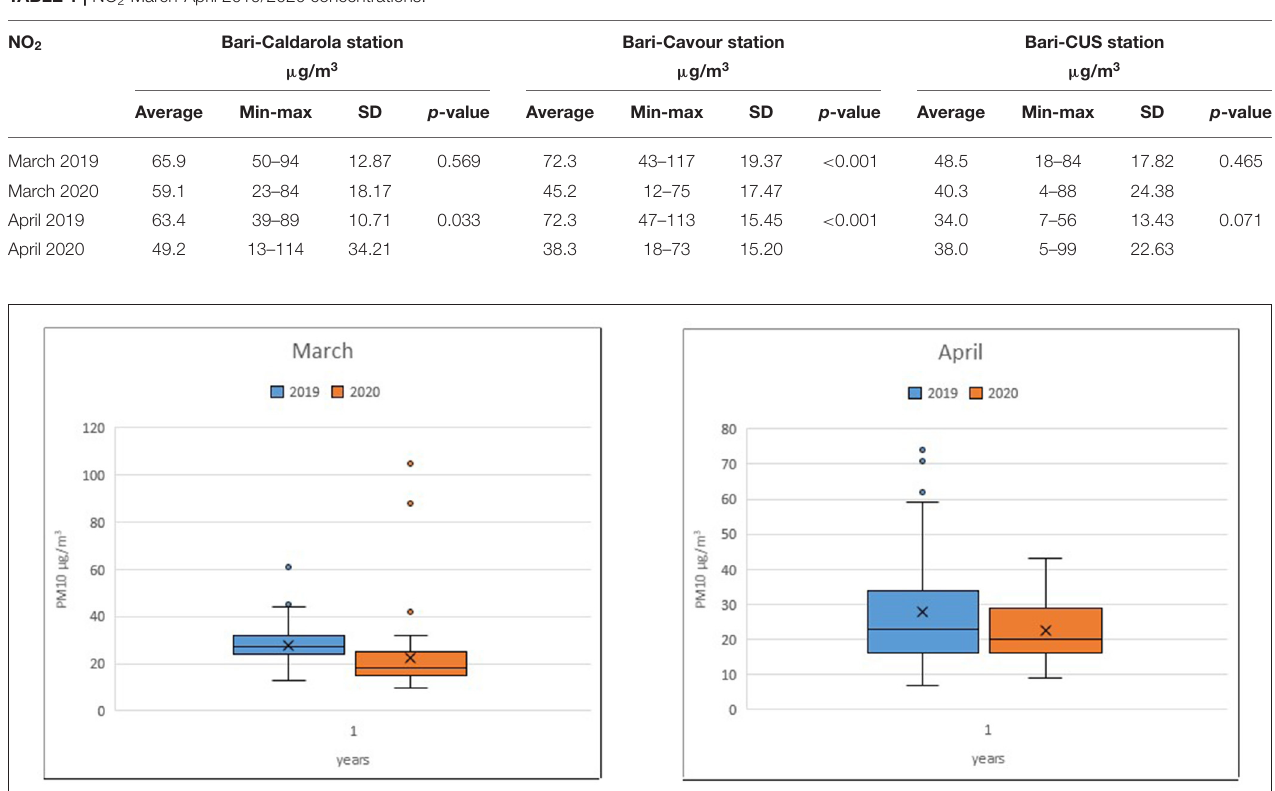
TABLE 1 | NO 2 March-April 2019/2020 concentrations.